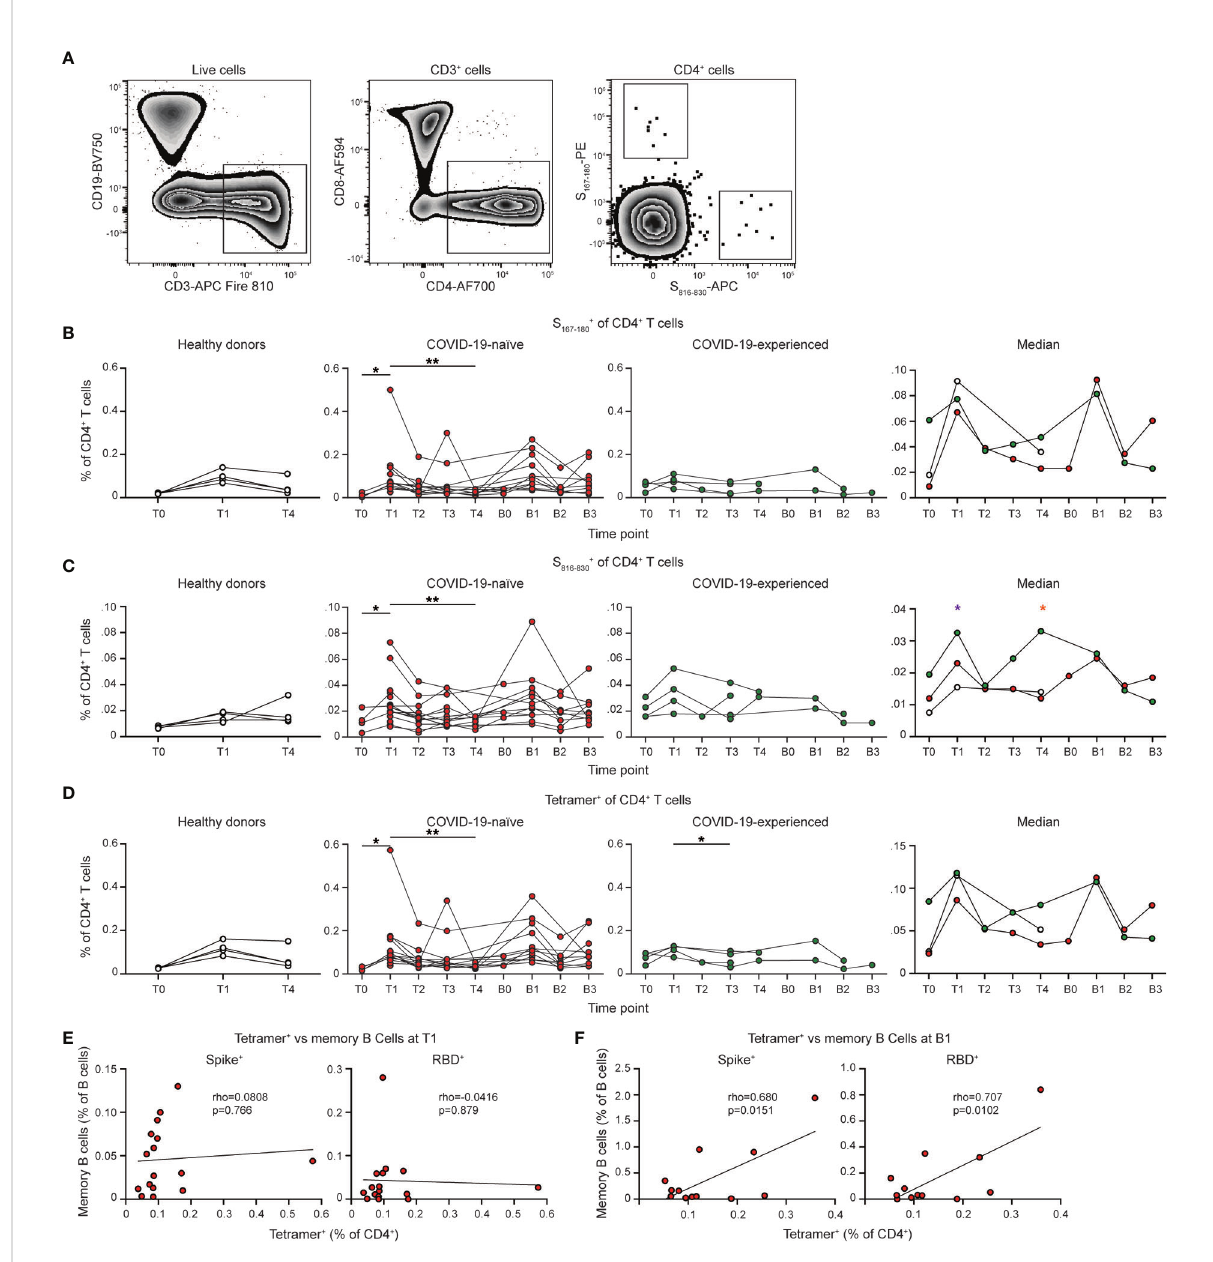
FIGURE 6 PAD patients display unimpaired SARS-CoV-2-speci fi c CD4 + T cell responses following vaccination. (A) Representative fl ow cytometry plots of the gating strategy used to identify S 167-180+ and S 816-830+ CD4 + T cells. Percentage of CD4 + (Live CD3 + CD19 - CD4 + CD8 - ) T cells that are (B) S 167-180+ , (C) S 816-830+ , or (D) Tetramer + (S 167-180+ or S 816-830+ ) in healthy donors (left, white), COVID-19-naïve PAD (middle left, red), and COVID-19-experienced PAD (middle right, green) cohorts. Median percentage of CD4 + T cells that comprise each population in all groups is shown on right. Correlation between percentage of B cells that are Spike + (left) or RBD + (right) memory (IgD lo CD20 + CD38 int-lo CD27 + ) cells and the percentage of CD4 + T cells that are Tetramer + at (E) T1 or (F) B1. Associations for (E, F) are calculated using Pearson rank correlation and shown with Pearson trend lines for visualization. Statistical analyses in (B – D) were performed using a mixed effects model (for trends found between time points) or two-way ANOVA (for trends found between groups shown on the median graphs) with Fisher ’ s least signi fi cant difference testing. Signi fi cance testing between time points was limited to comparisons relative to T1. Above the median graphs, an orange asterisk indicates a comparison between the COVID-19-naïve and COVID-19-experienced groups, and a purple asterisk indicates a comparison between the COVID-19-experienced and healthy donor groups (* p < 0.05; ** p < 0.01).